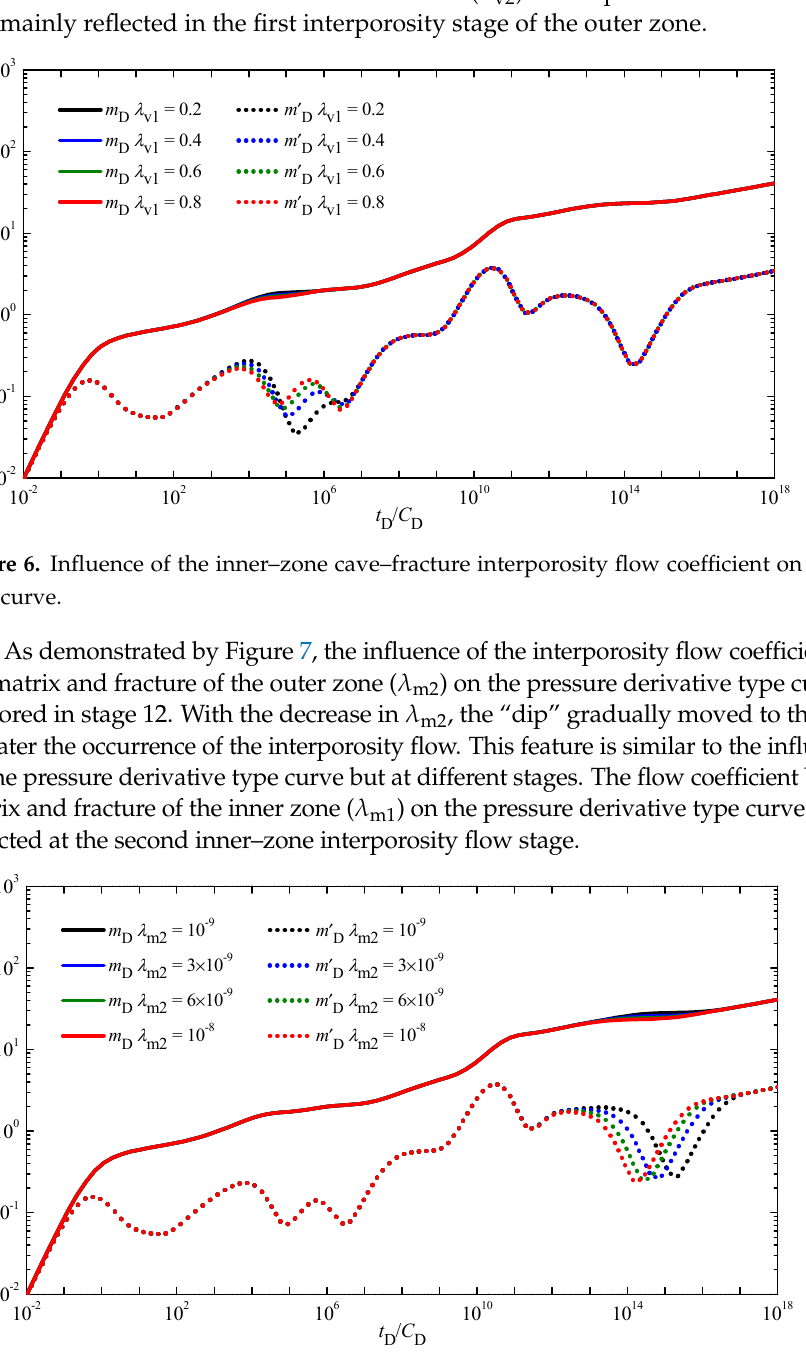
t D / C D Figure 8. Influence of the inner–zone fracture storage ratio on the pressure type curve. The influence of the matrix storage ratio of the outer zone ( ω m2 ) (Figure 9) on the derivative curve was most mirrored in stage 9 to stage 12. Similarly, the effect of the matrix